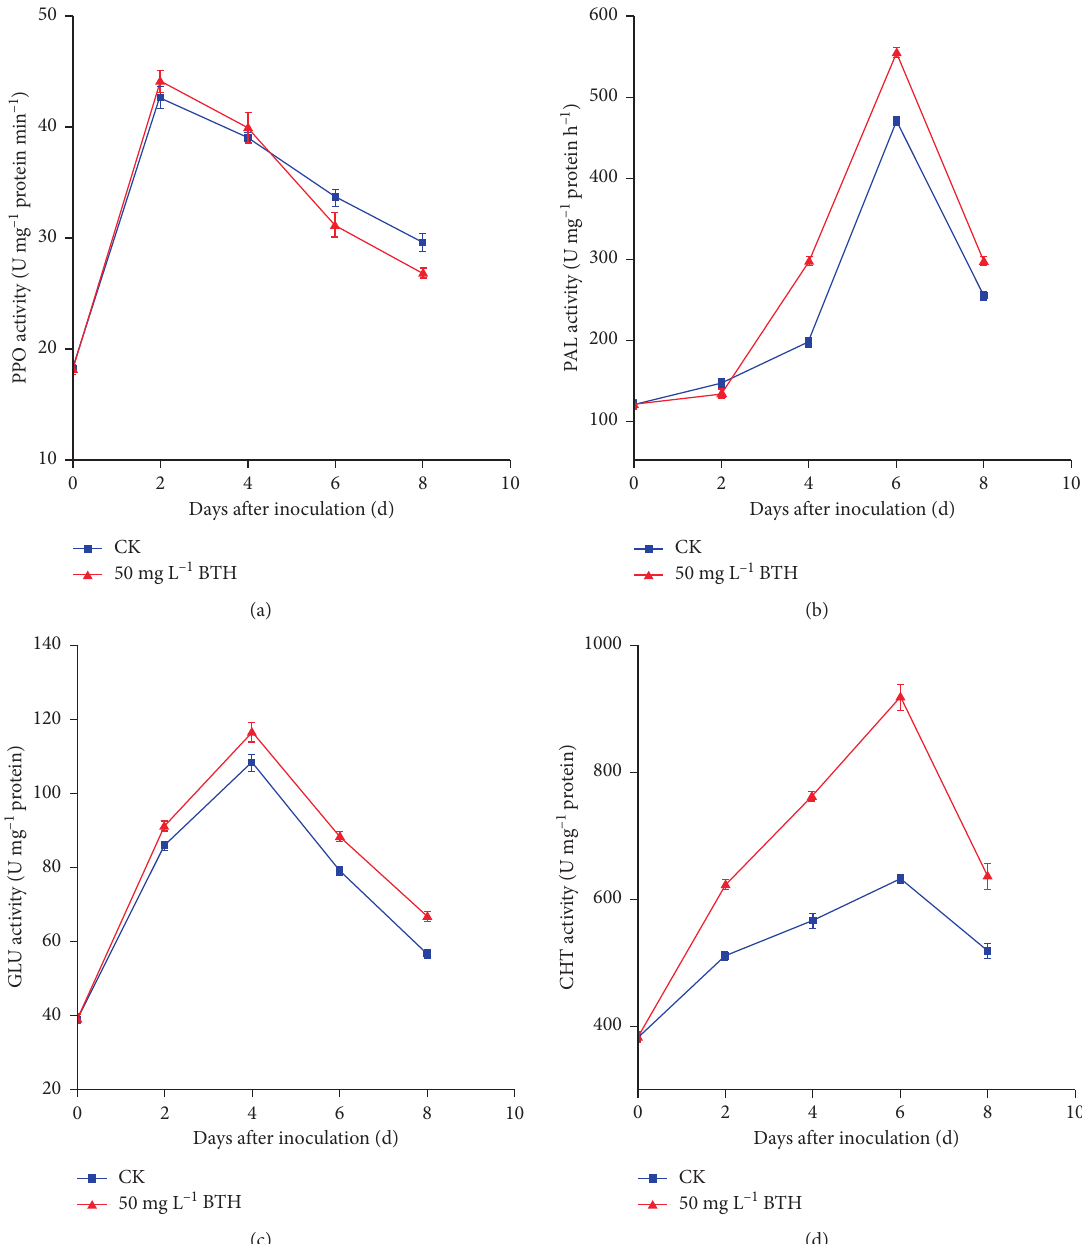
Figure 5: Effects of BTH on PPO, PAL, GLU, and CHT activities in navel orange fruits challenged with P. italicum